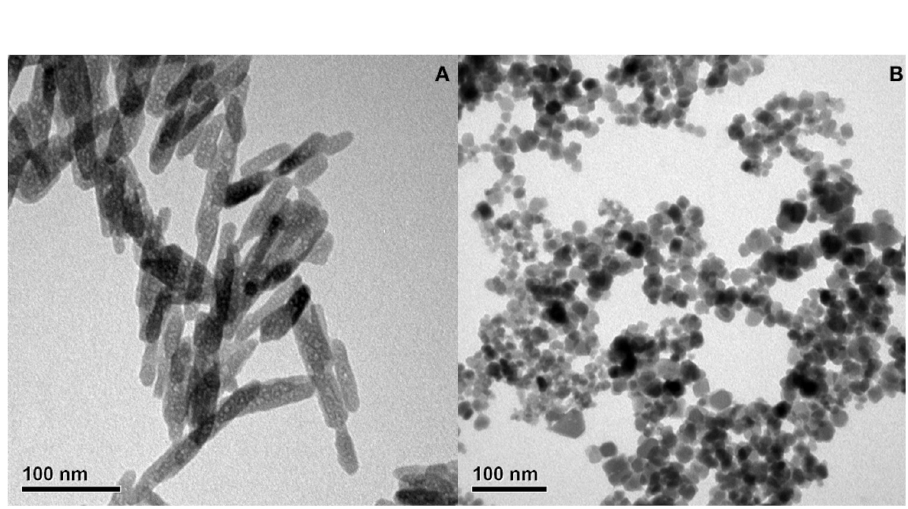
Fig 2. TEM images of (A) MNP and (B) HAP; the diameter MNP was approximately 10 nm and the size of HAP was approximately 10 nm in width and 100–150 nm in length.